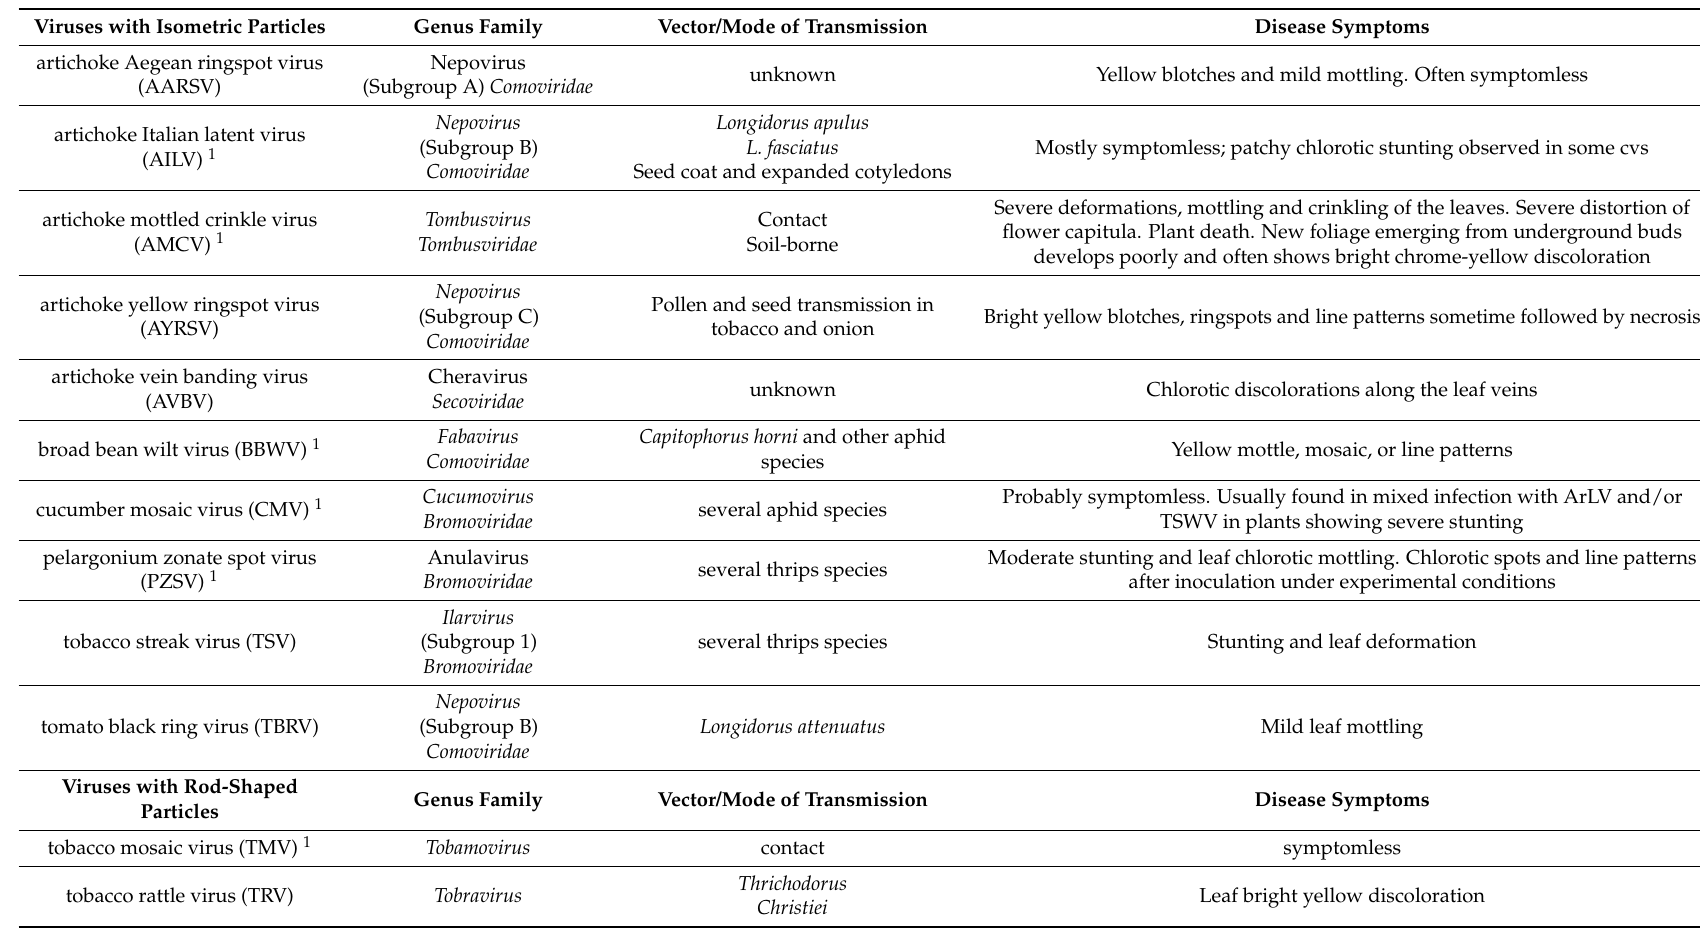
Table 1. Viruses infecting globe artichoke in nature: taxonomic allocation, epidemiology, and disease